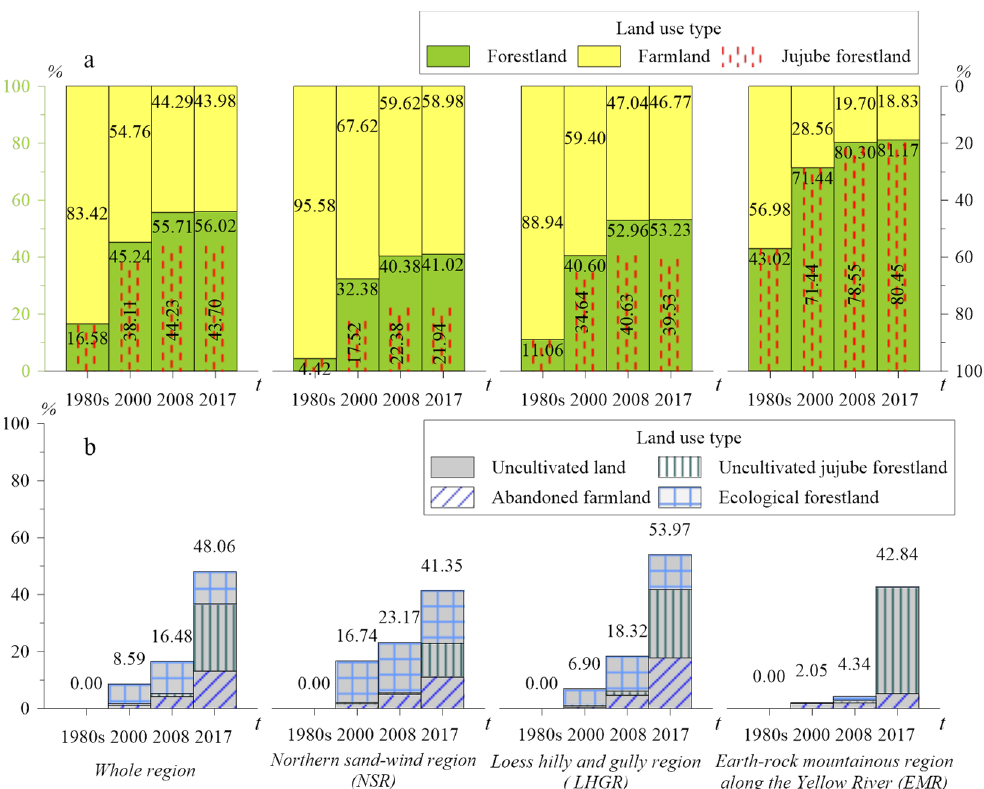
Figure 4. Proportion and changes in land use categories in different regions since 1980s.